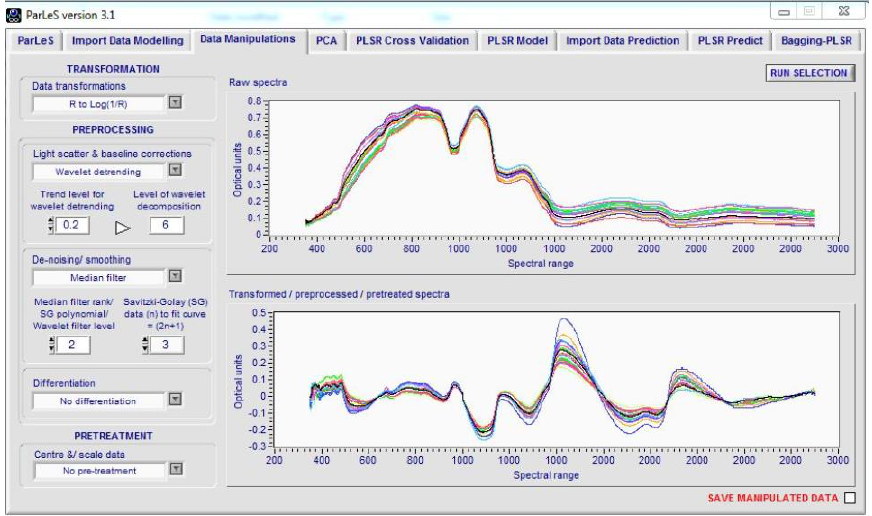
Figure 4. Sample application of ParLeS software (version 3.1) to preprocess the obtained spectral data for different potato samples.